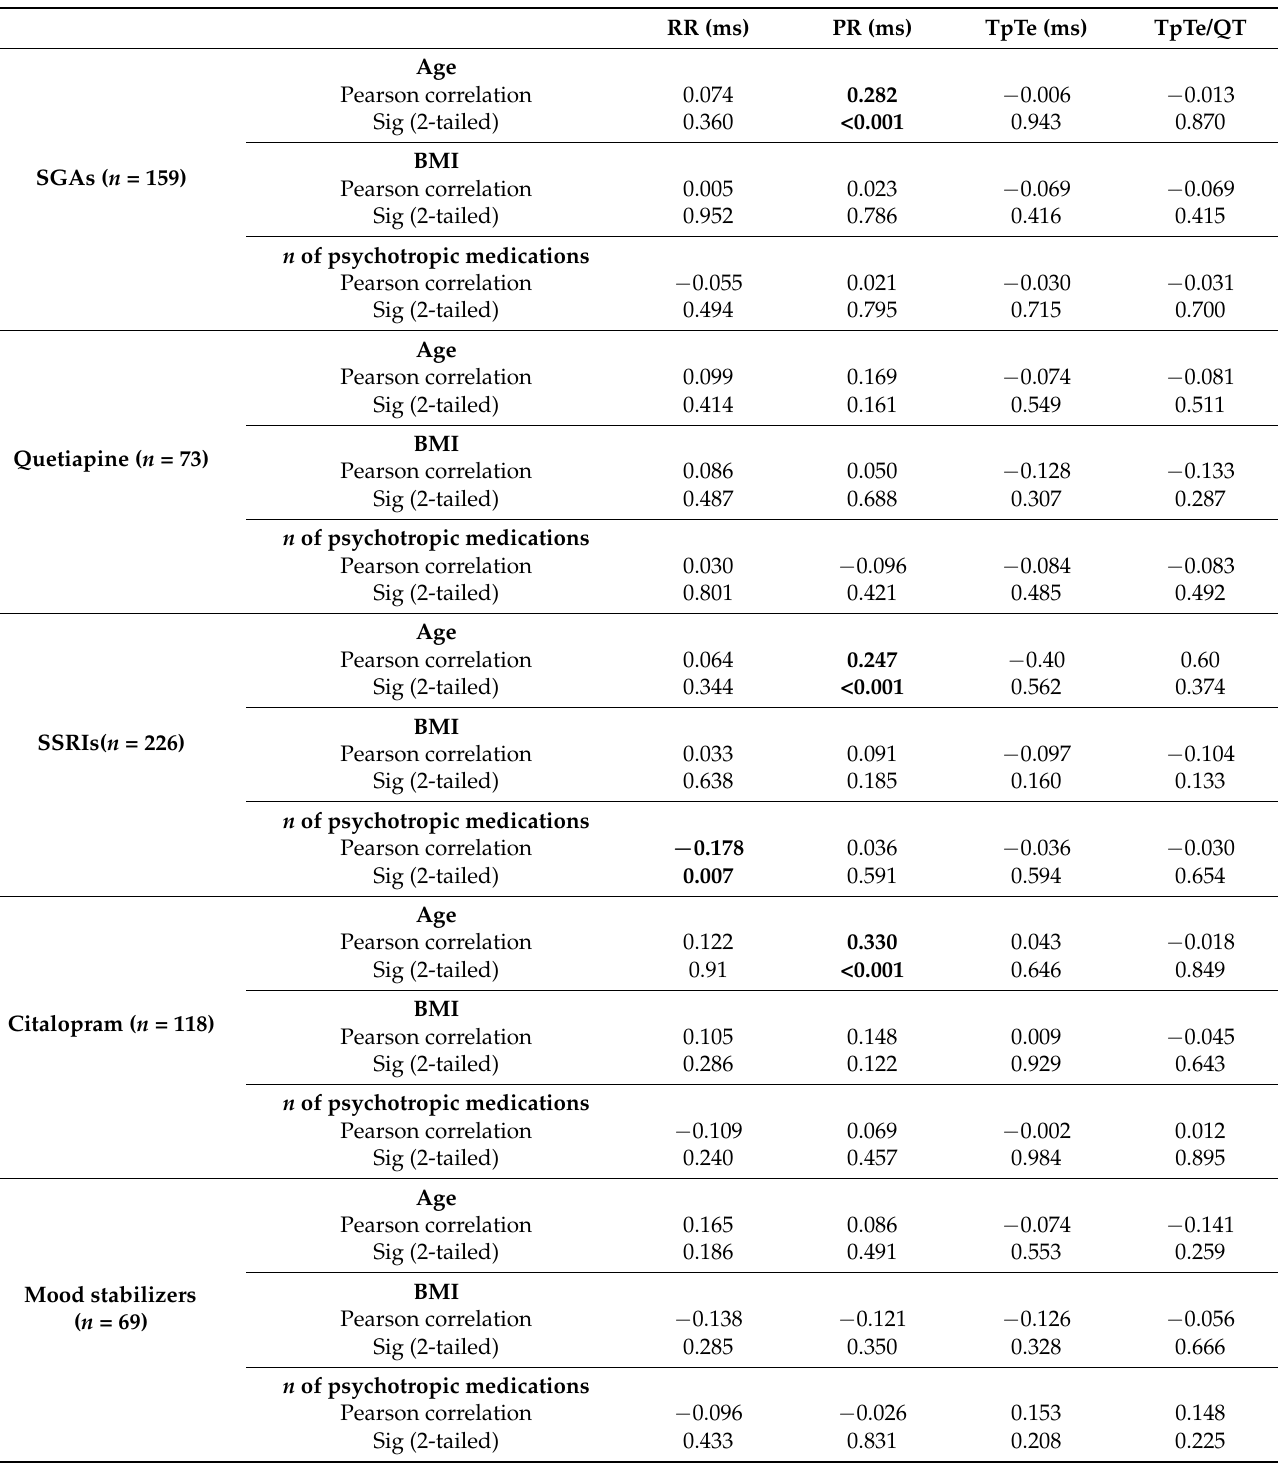
Table 5. Correlations of RR, PR TpTe intervals and TpTe/QT with age, BMI and number of psy- chotropic drugs in the total sample and in patients prescribed the most common psychotropic